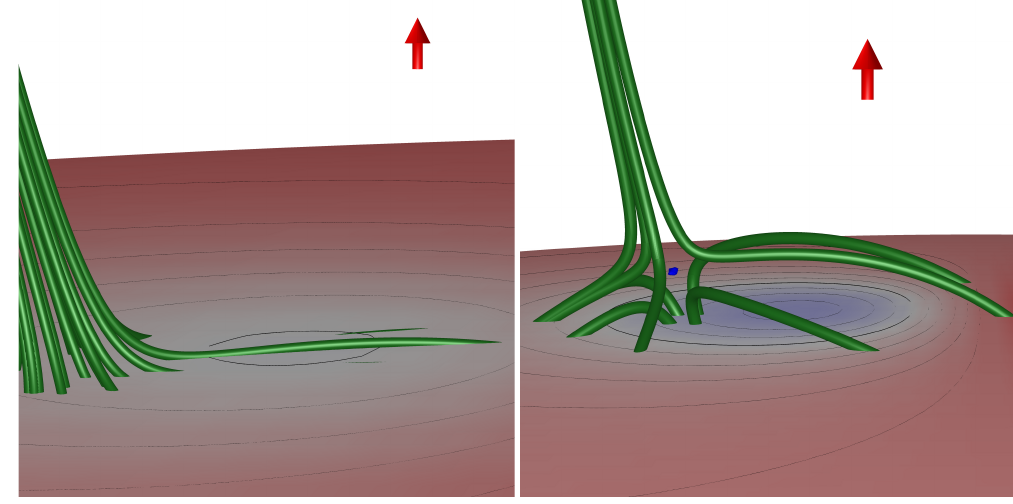
Fig. 8. Magnetic field lines around the polarity inversion line at 80 ◦ latitude (close to the pole) for dipole strengths of 2 . 5 × 10 − 4 and 4 × 10 − 4 . The left plot shows a (very shallow) bald patch topology, while the right one shows a null point topology. The red arrows point